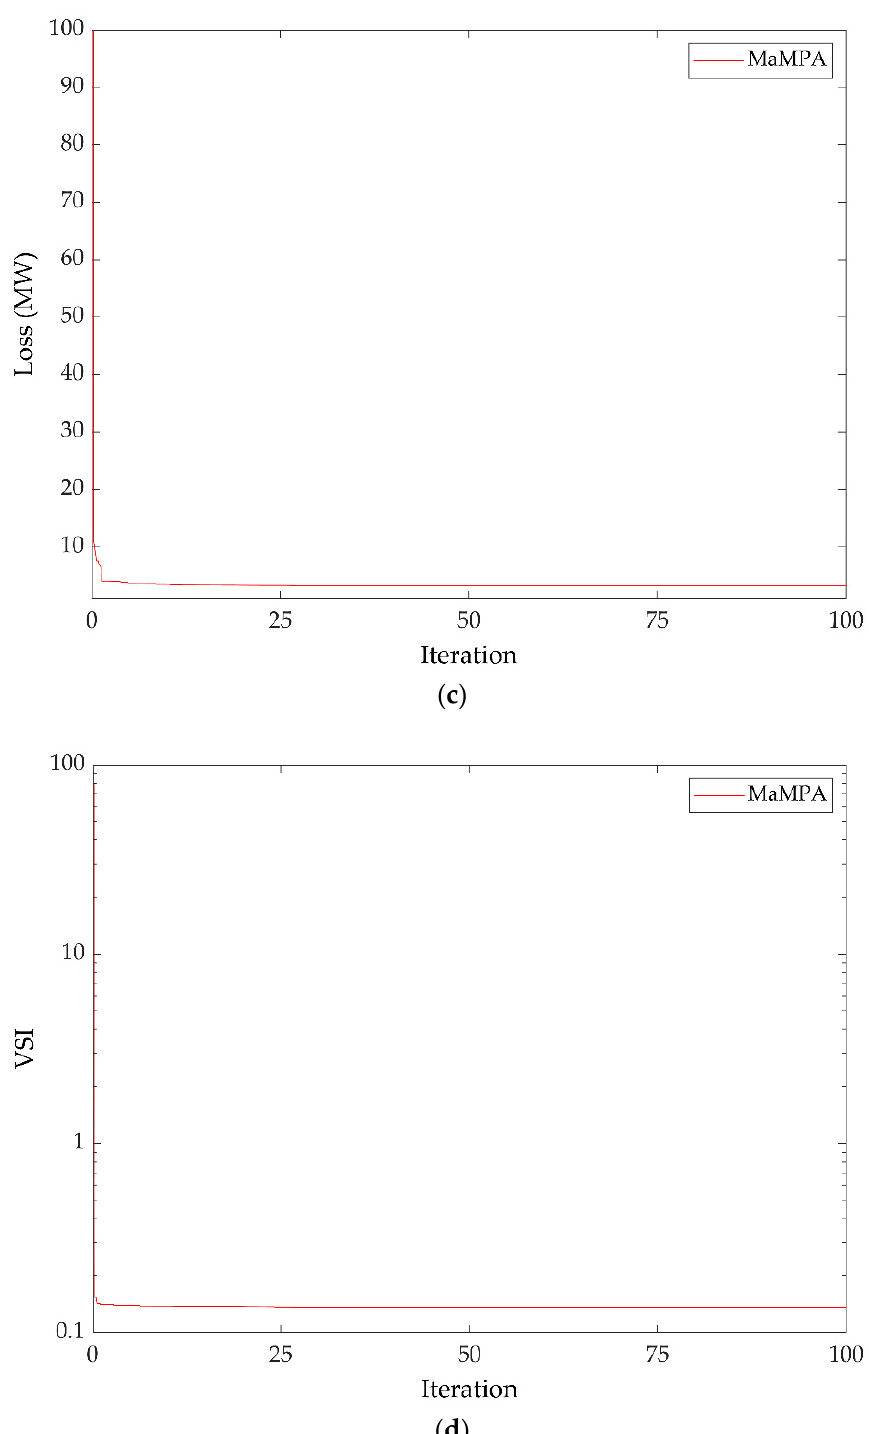
Figure 2. Convergence curves of MaMPA for: ( a ) case 1; ( b ) case 2; ( c ) case 3; ( d ) case 4.